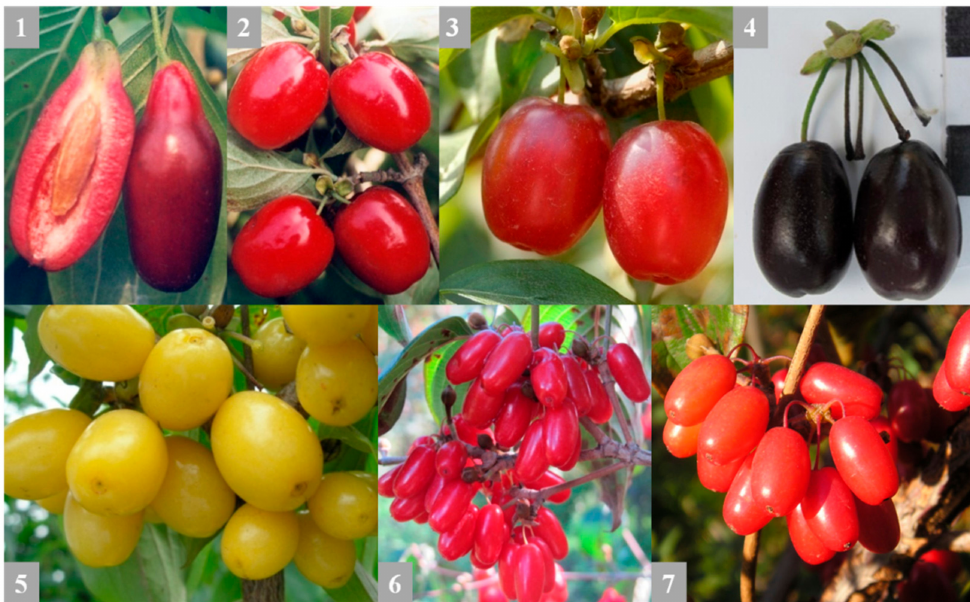
Figure 1. Fruits of different cultivars of Cornus mas L. (1—Ekzotychnyi; 2—Koralovyi Marka; 3—Koralovyi; 4—Uholok; 5—Yantarnyi), C. officinalis Siebold & Zucc. (6) and C. mas × C. officinalis (7) of a selection of M.M. Gryshko National Botanical Garden (Kyiv,